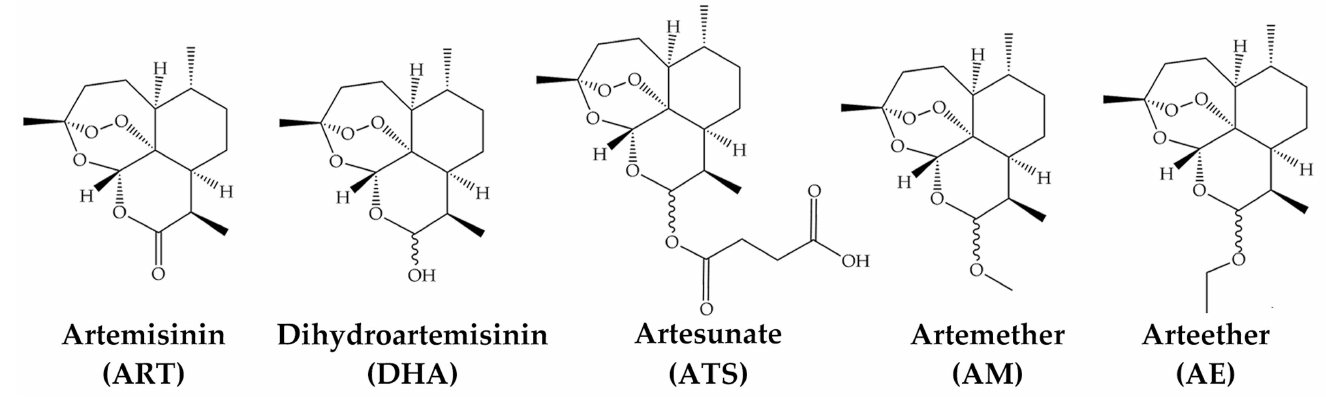
Figure 1. Artemisinin and four derivatives in clinical